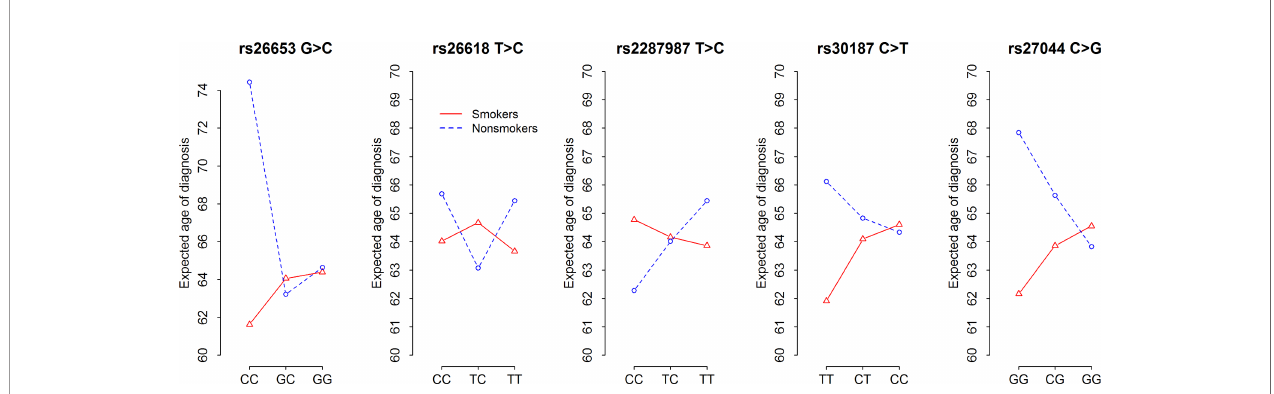
FIGURE 2 | Expected age at diagnosis of NSCLC according to fi ve ERAP1 SNPs and smoking status. F-statistics and p-values of ANOVA tests for contrasts presented in Supplementary Table 6